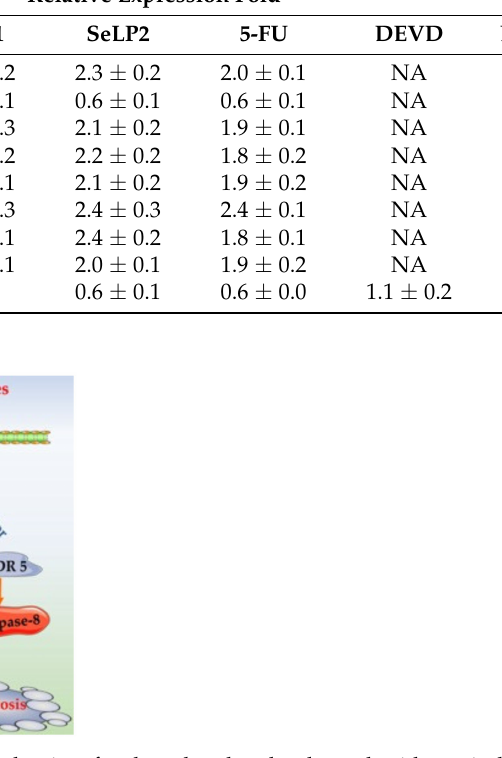
Figure 7. The underlying mechanism for the selenylated polysaccharides to induce cell